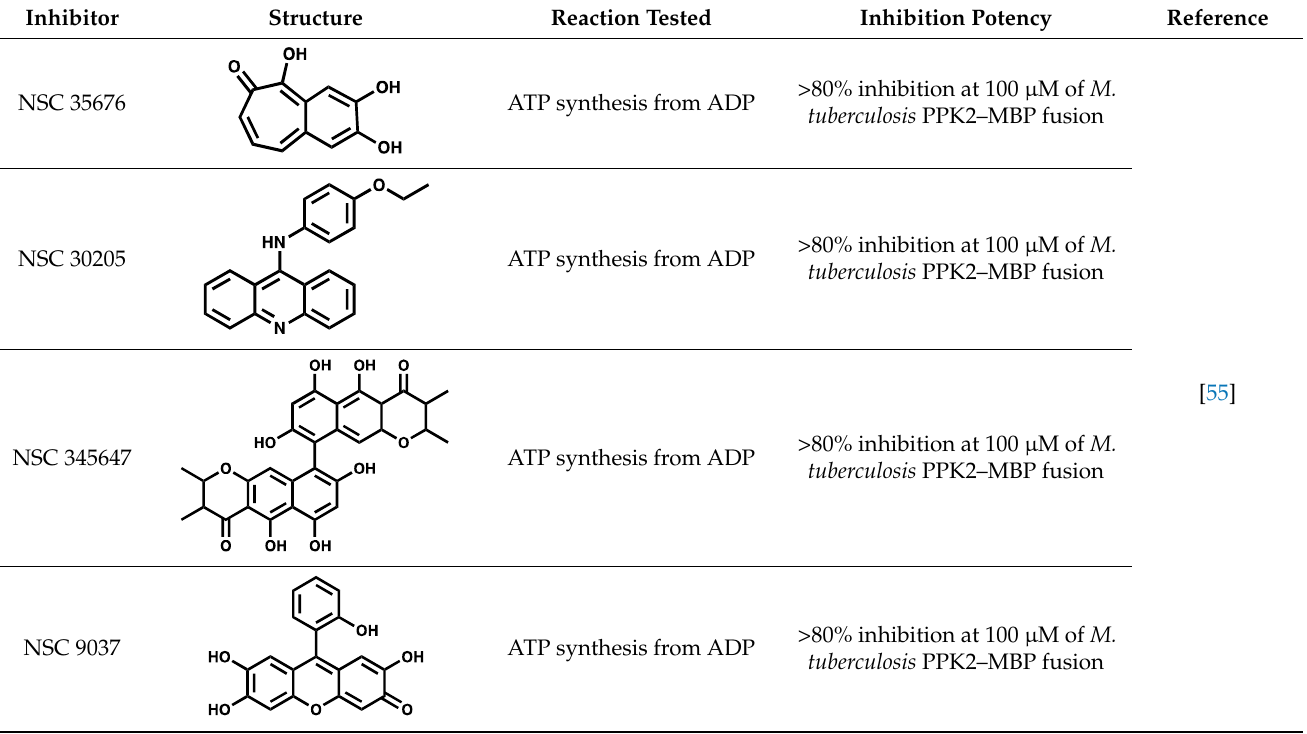
Table 2. Chemical structures and activities of PPK2 inhibitors.